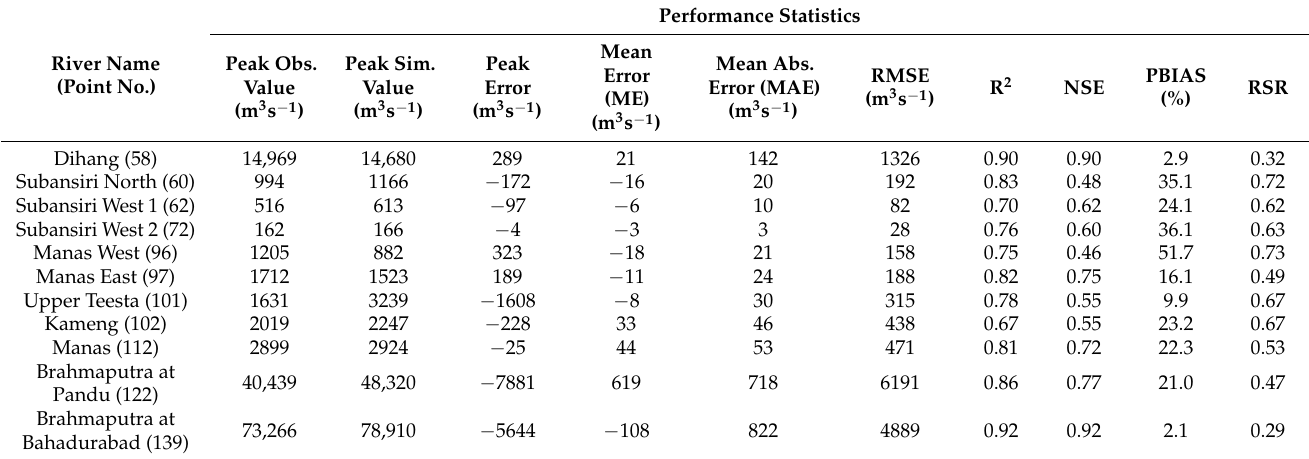
Table 5. Brahmaputra SWAT model performance for different